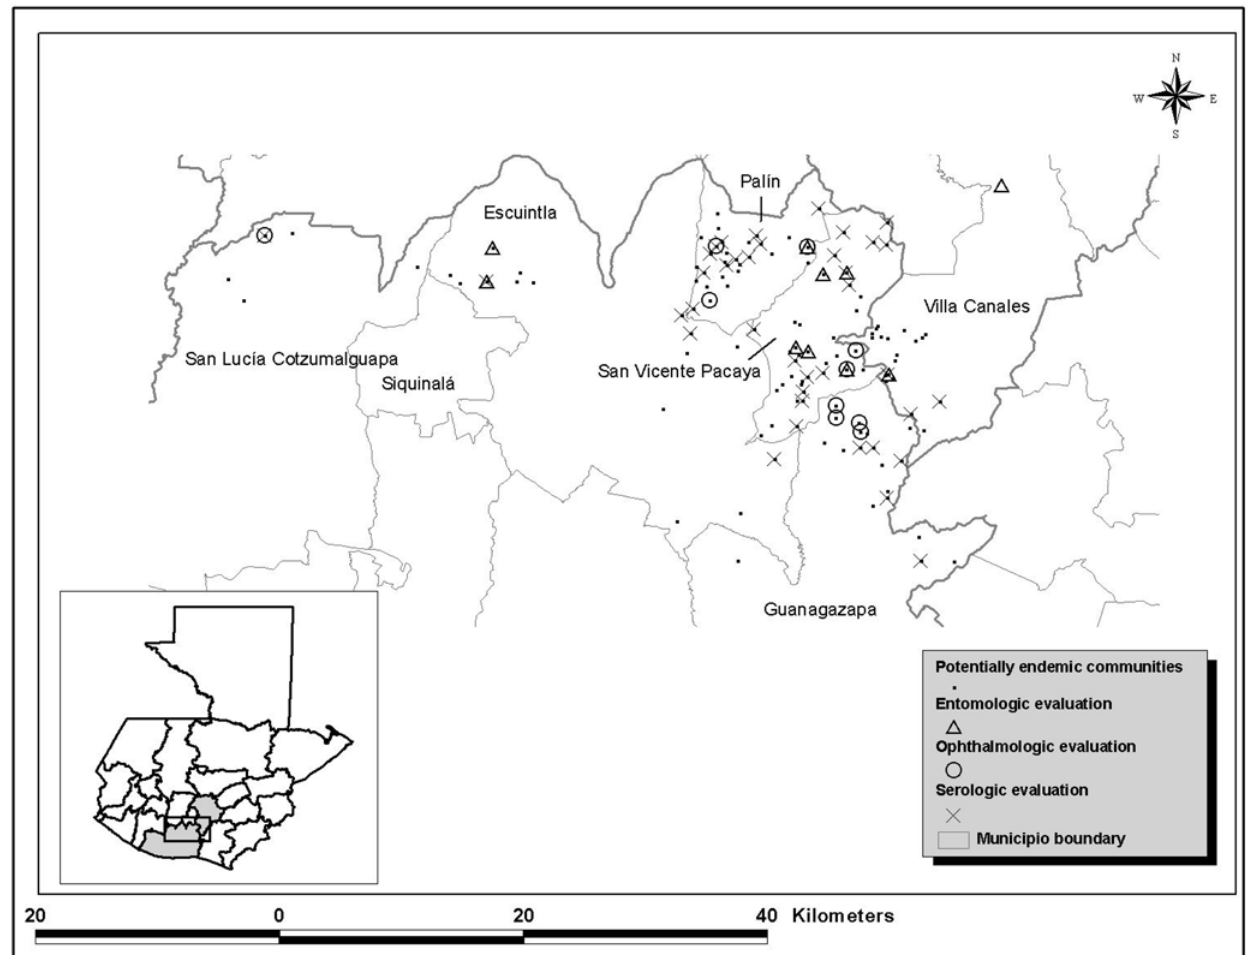
Figure 3. Potentially endemic communities and sites for the entomologic, ophthalmologic and serologic evaluations in the Escuintla-Guatemala